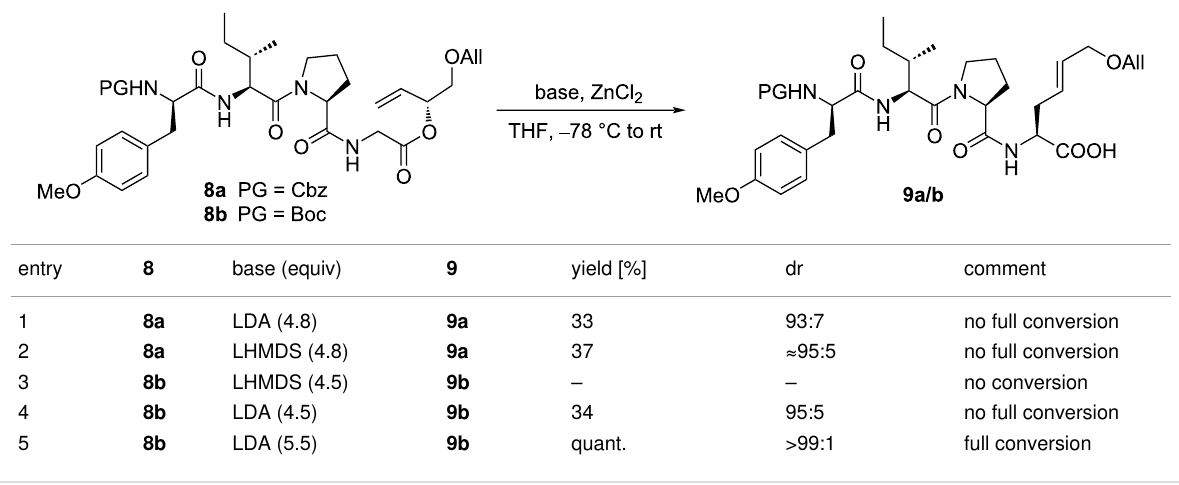
Table 1: Ester enolate Claisen rearrangements of tetrapeptide allyl esters 8 .